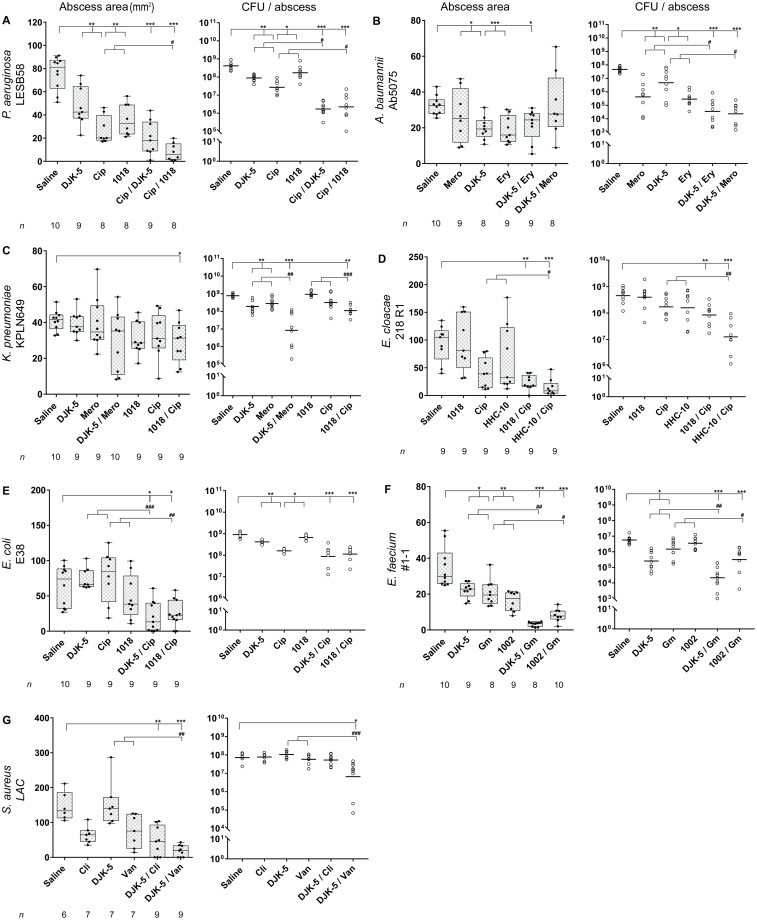
Antibiotic and synthetic peptide mono- and combinatorial therapy in a murine cutaneous abscess model using female CD-1 mice and clinical drug-resistant bacterial isolates.Bacterial strains were injected subcutaneously and treated one hour post infection with either saline (control), synthetic peptides, antibiotics, or antibiotic-peptide combinations. Synthetic peptide concentrations for all conditions were as follows: 1002, 10 mg/kg (3 mg/kg for E. faecium); 1018, 10 mg/kg; HHC-10 10 mg/kg, and DJK-5, 3 mg/kg (0.25 mg/kg for S. aureus). Infected and inflamed tissue was measured three days post infection and pus-containing abscess lumps excised to determine CFU. Abscess sizes are in box and whiskers plots (left panel) and counted CFU/abscess data expressed with geometric mean (right panel). A. P. aeruginosa LESB58, ciprofloxacin 0.4 mg/kg. B. A. baumannii Ab5075, erythromycin 6 mg/kg, meropenem 6 mg/kg. C. K. pneumoniae KPLN649, meropenem 10 mg/kg, ciprofloxacin 30 mg/kg. D. E. cloacae 218 R1, ciprofloxacin 0.006 mg/kg. E. E. coli E38, ciprofloxacin 4 mg/kg, F. E. faecium #1–1, gentamicin 16 mg/kg. G. S. aureus LAC, clindamycin 0.01 mg/kg; vancomycin 0.15 mg/kg. (A-G)
n = 368 biologically independent animals. All experiments were done at least three times with 2–4 mice/group. Statistical analysis was performed using One-way ANOVA, Kruskal-Wallis test with Dunn’s correction (two-sided). The asterisk indicates significant differences to the wild-type (*, p < 0.05; **, p < 0.01; ***, p < 0.001). The hash indicates significant differences of the combination therapy over the sum of the effects of each agent alone (#, p < 0.05; ##, p < 0.01; ###, p < 0.001).